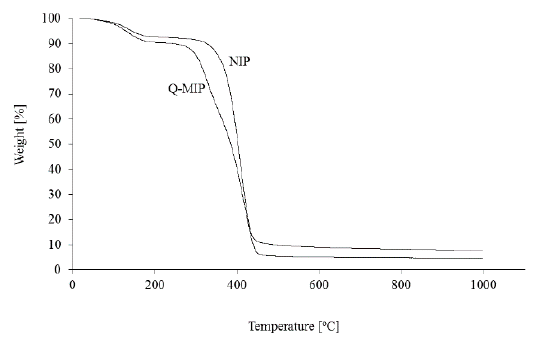
Figure 1. Thermogravimetric curves for Q-MIP and non-imprinted polymer (NIP).